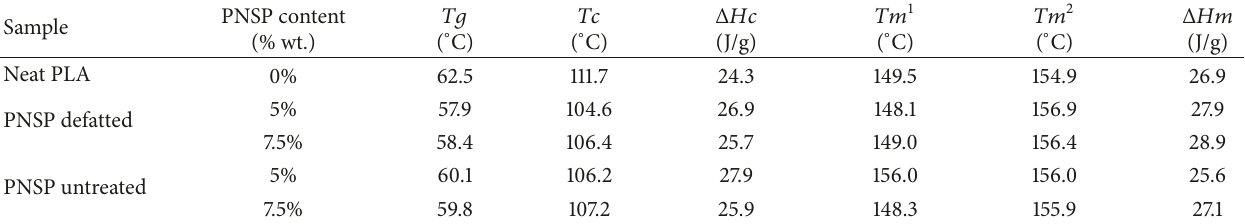
Table 3: Thermal data measurements obtained by differential scanning calorimetry of the PLA-PNSP biocomposites.